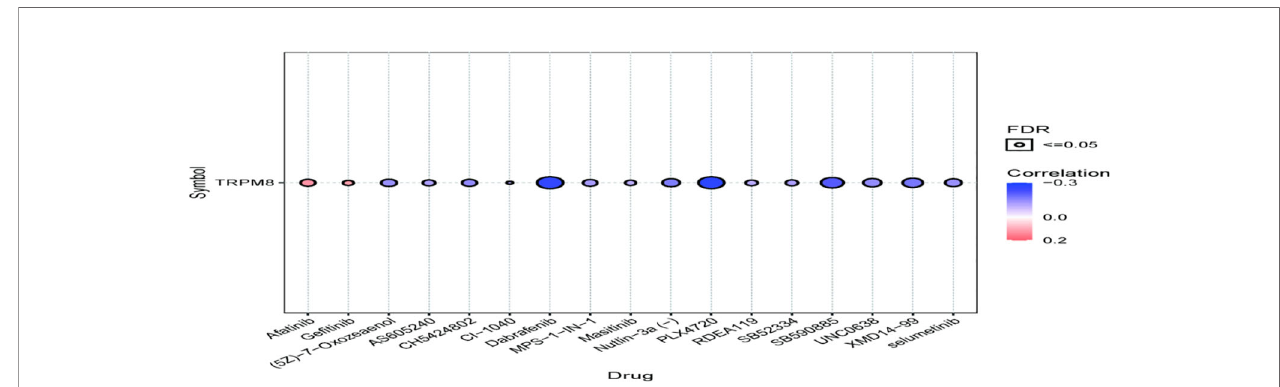
FIGURE 13 | Association between TRPM8 and drug (top 30) sensitivity, shown by GDSC